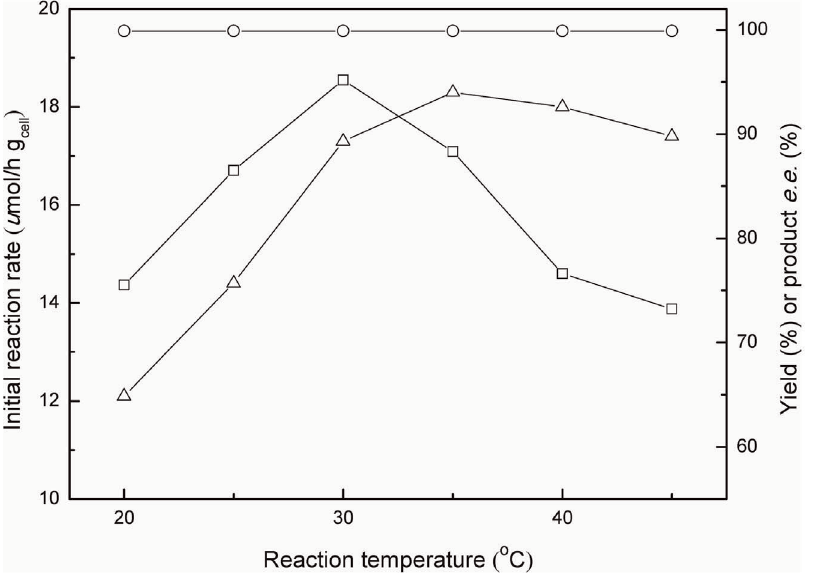
Figure 5. Effect of reaction temperature on the bioreduction of TMSB. Symbols: ( g ) the initial reaction rate; ( % ) the maximum product yield; ( # ) the product e.e. All products have the ( S ) configuration. Reaction conditions: 3.0 mmol/L TMSB, 4.0 mL TEA-HCl buffer (100 mmol/L, pH 5.0) containing 10% (v/v) C 2 OHMIM ? NO 3 , 98.1 mmol/L 2-propanol, and 0.15 g/mL immobilized C. parapsilosis cells, various reaction temperatures, 180 r/ min.